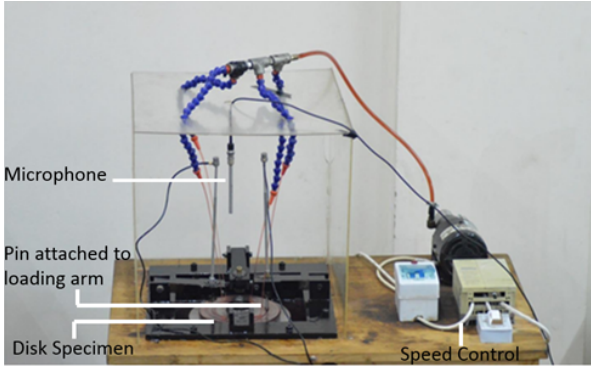
Figure 1. Pin on disc tribometer.